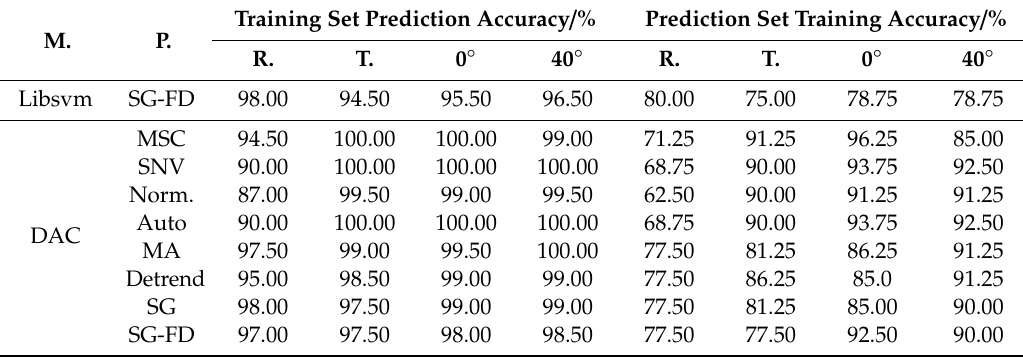
Table 5. The accuracy of the modeling based on SPA (the table shows the higher accuracies). M.